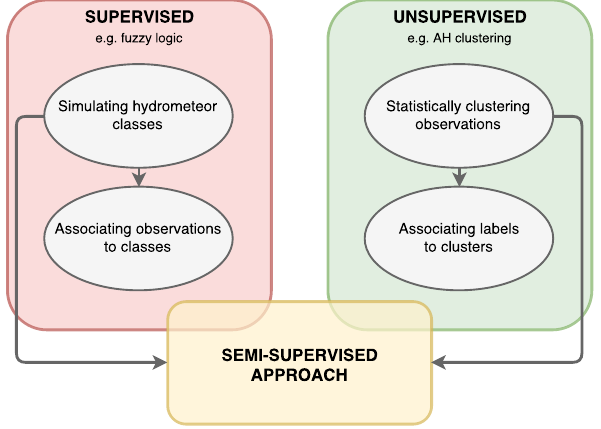
Figure 1. Schematic generalisation of hydrometeor classification